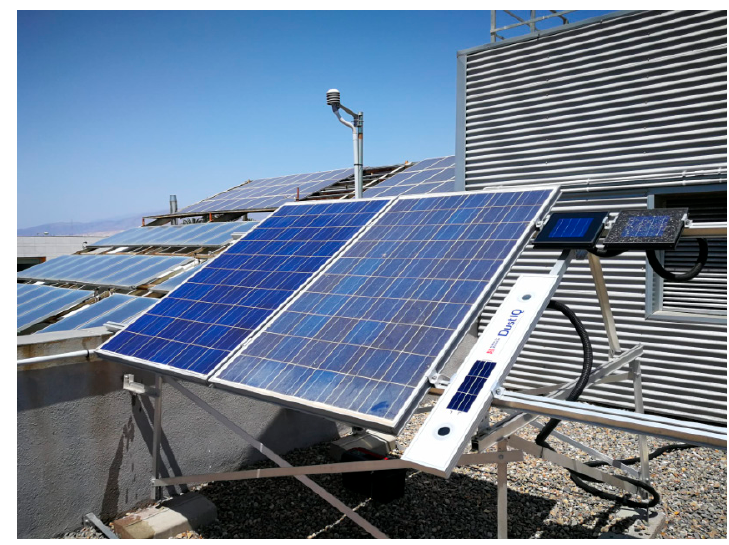
Figure 1. Monitored experimental installation.